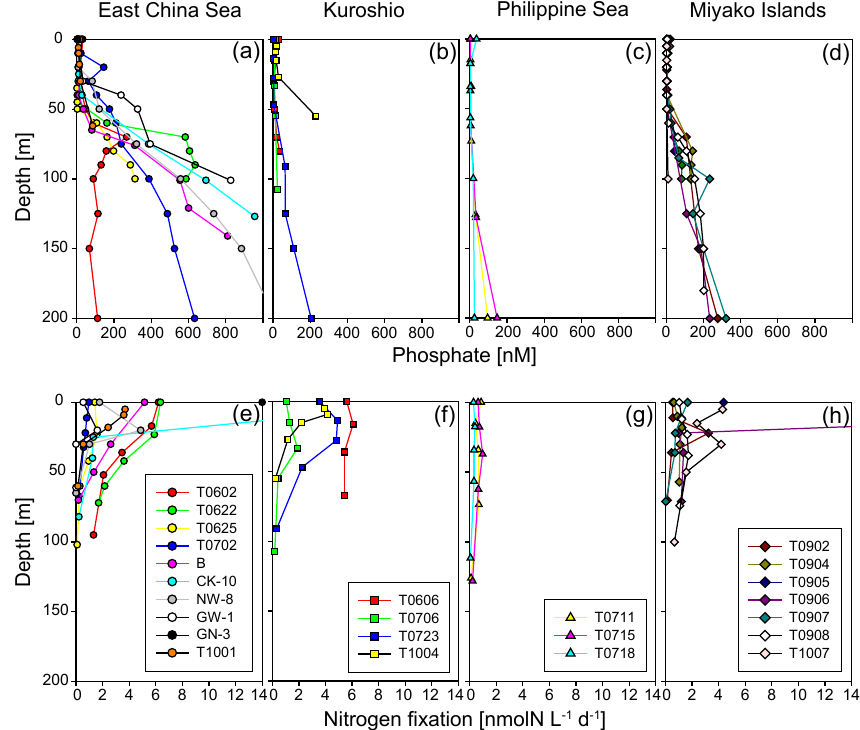
Figure 3. Vertical profiles of phosphate and nitrogen fixation in the East China Sea (a, e) , the Kuroshio (b, f) , the Philippine Sea (c, g) , and the Miyako Islands (d, h) .